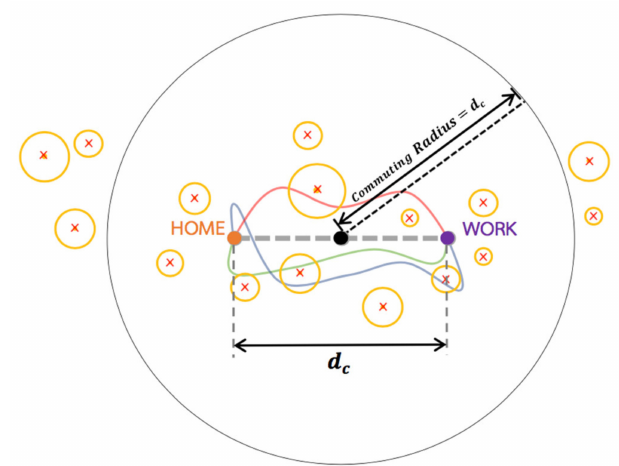
Figure 15. Illustrating graphics showing how the commuting-radius based noise filtering works. Cell towers located within the commuting-radius ( d c ) scope are taken further for the route choice inference while those located outside the scope are considered as noise and